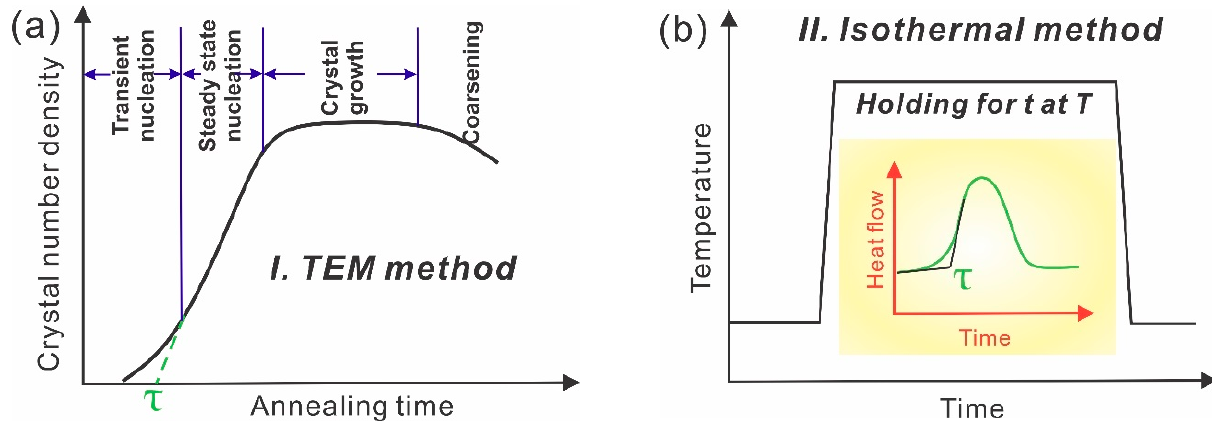
Figure 2. Schemes of traditional experimental methods to determine the delay time τ for primary crystallization in MGs: ( a ) TEM method (I); ( b ) isothermal method based on the thermal tests (II). The inserted graph in ( b ) gives the confirmation details of delay time by method II.